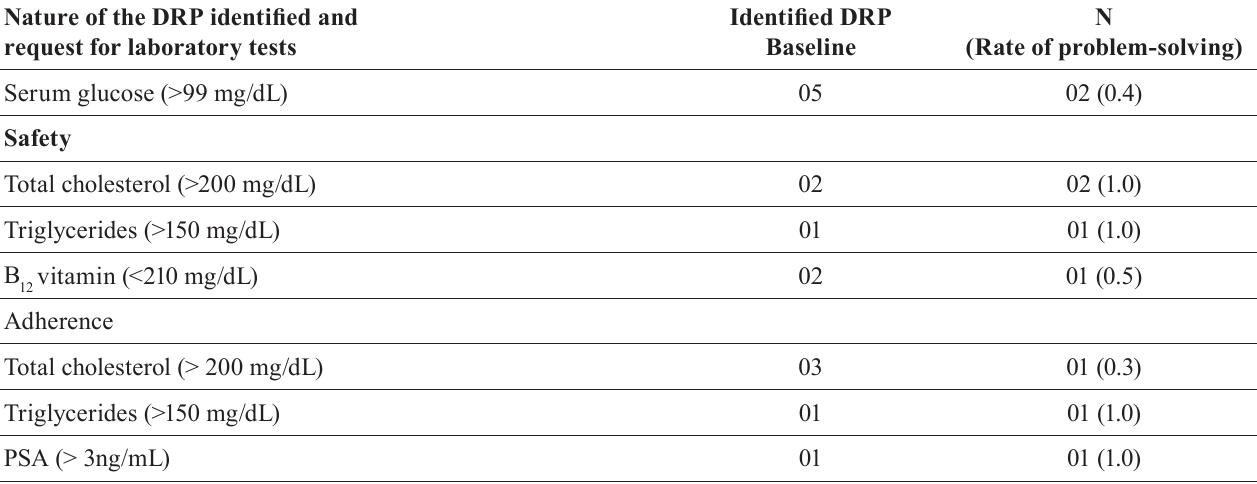
TABLE IV - Request for laboratory tests to identify and monitor the Drug Related Problem (DRP) identified and the respective rate of problem-solving indices by the Medication Therapy Management, Araraquara Nature of the DRP identified